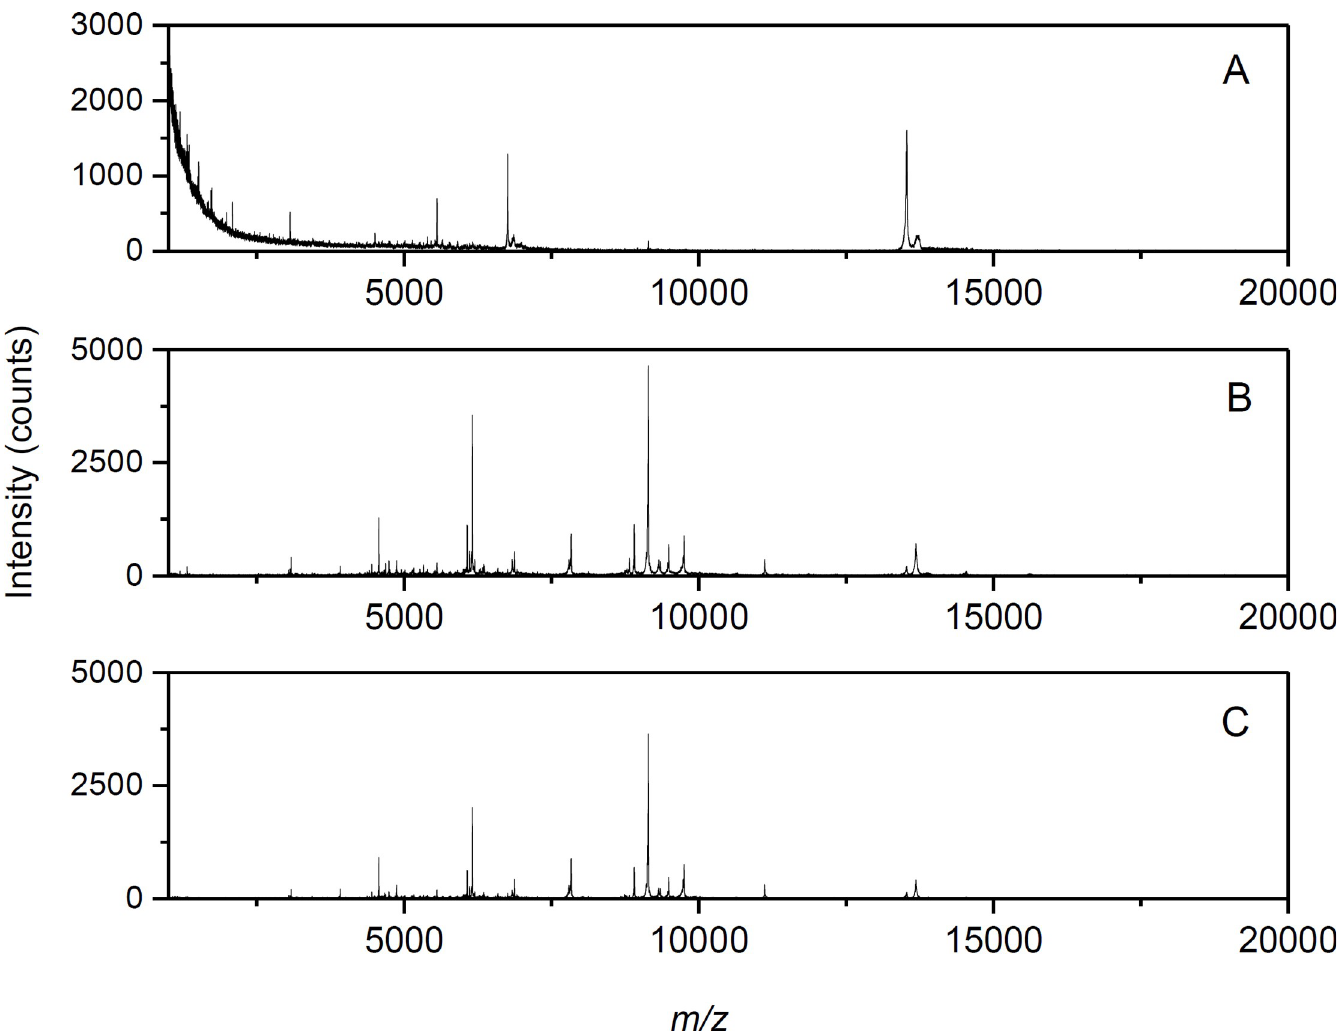
Fig 1. Intact cell MALDI-MS of cyanobacteria: the use of different TFA concentrations. The measurements were carried out on Microflex LRF20 MALDI-TOF instrument with Chroococcidiopsis cubana (UPOC 18/2013) cells and a binary matrix composed of FA and SA (5:15 mg � ml -1 ) dissolved in ACN/TFA, 7:3, v/v. The dried-droplet sample preparation technique was used and the TFA concentration prior to mixing with ACN was 0.1%, v/v (panel A), 2%, v/v (panel B) or 5%, v/v (panel C). As can be seen, choosing 2% TFA resulted in spectra of the highest quality.